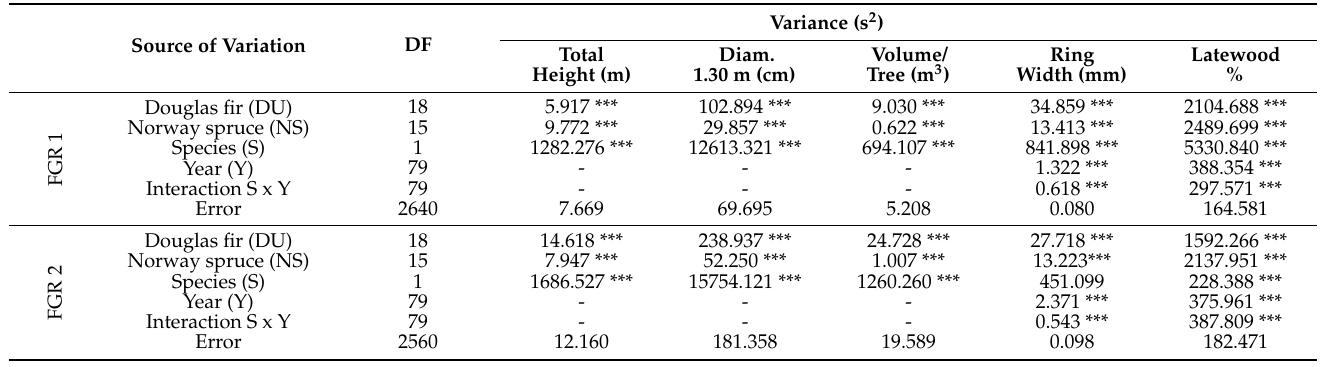
Table 3. Analysis of variance of growth and wood traits for the studied